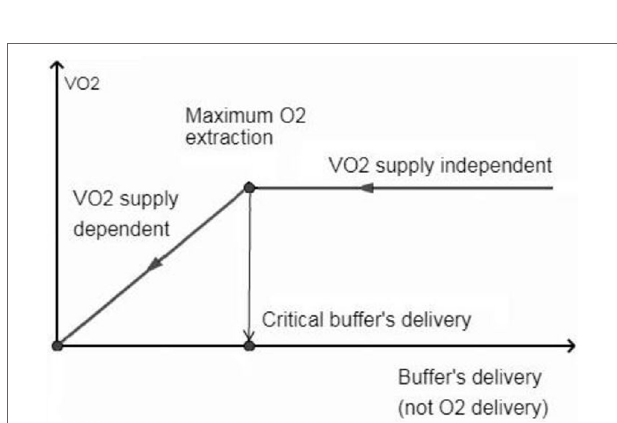
FigURE 2 | Oxygen consumption (VO 2 ) is independent when perfusion allows hemoglobin not to be fully saturated with protons. From the critical buffer’s delivery or maximum O 2 extraction point, the CO 2 abruptly accumulates in the brain tissue, causing VO 2 dependence on blood flow buffering capacity (not on O 2 delivery) to counteract the life threatening acidosis.